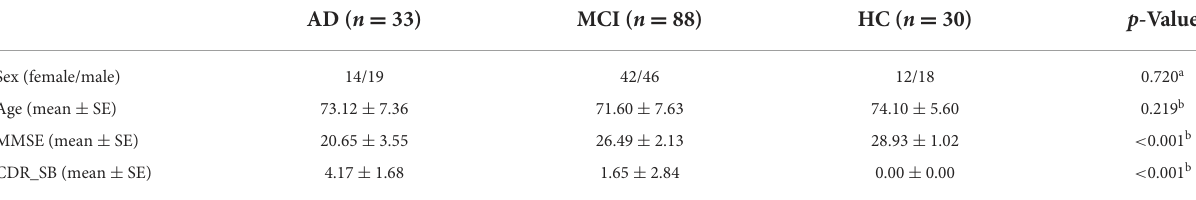
TABLE 1 Demographic and clinical information of